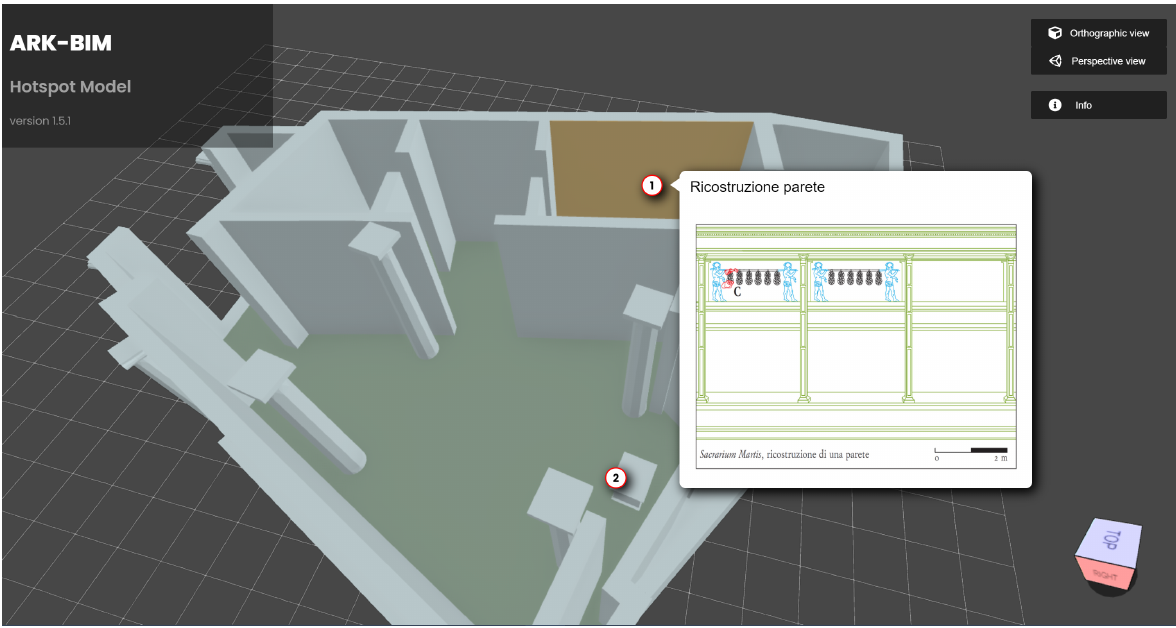
Figure 15. ARK-BIM (version 1.5.1): Hotspot Model plugin, sample with an image reference.